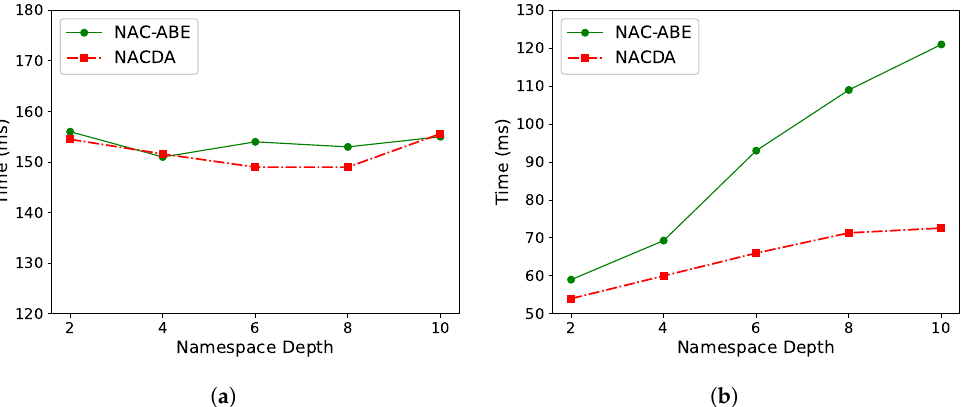
Figure 11. Publishing/Receiving Comparison with Different Namespace Depths: ( a ) Publishing Com- parison with Different Namespace Depths; ( b ) Receiving Comparison with Different Namespace